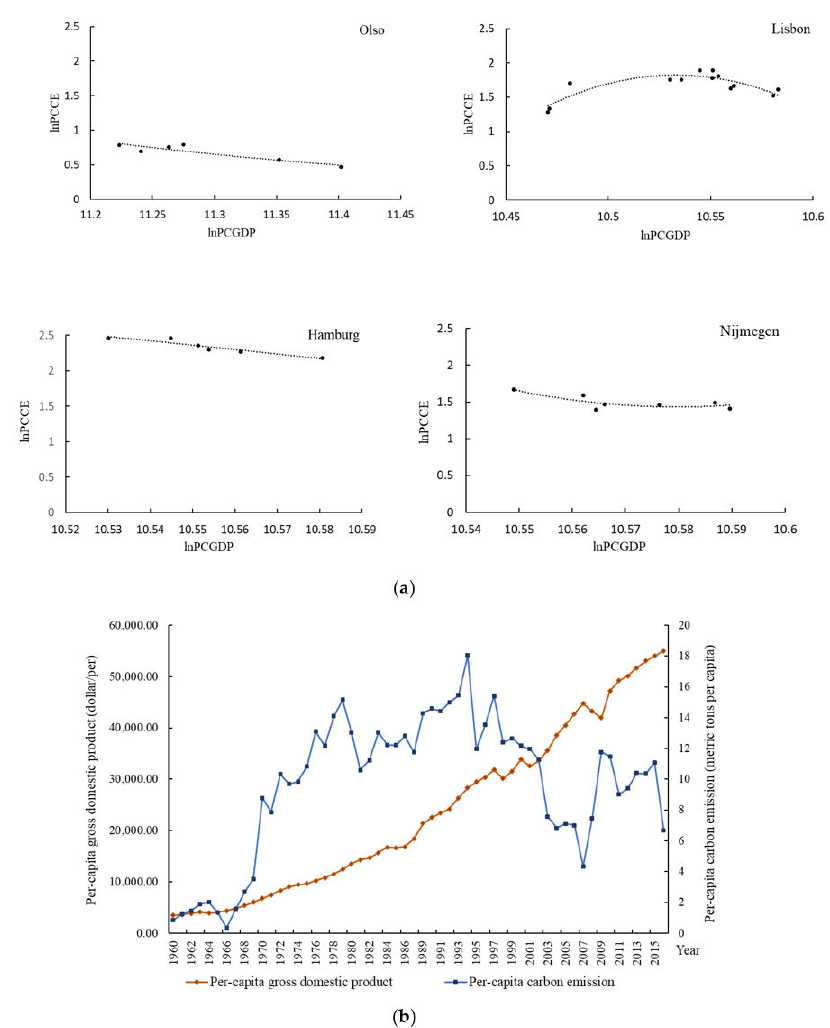
Figure 3. ( a ) Changes of per capita gross domestic product (PCGDP) and PCCE in potential best practice areas [47]. (Oslo, Lisbon, Hamburg, and Nijmegen) . ( b ) Changes of PCGDP and PCCEs in potential best practices